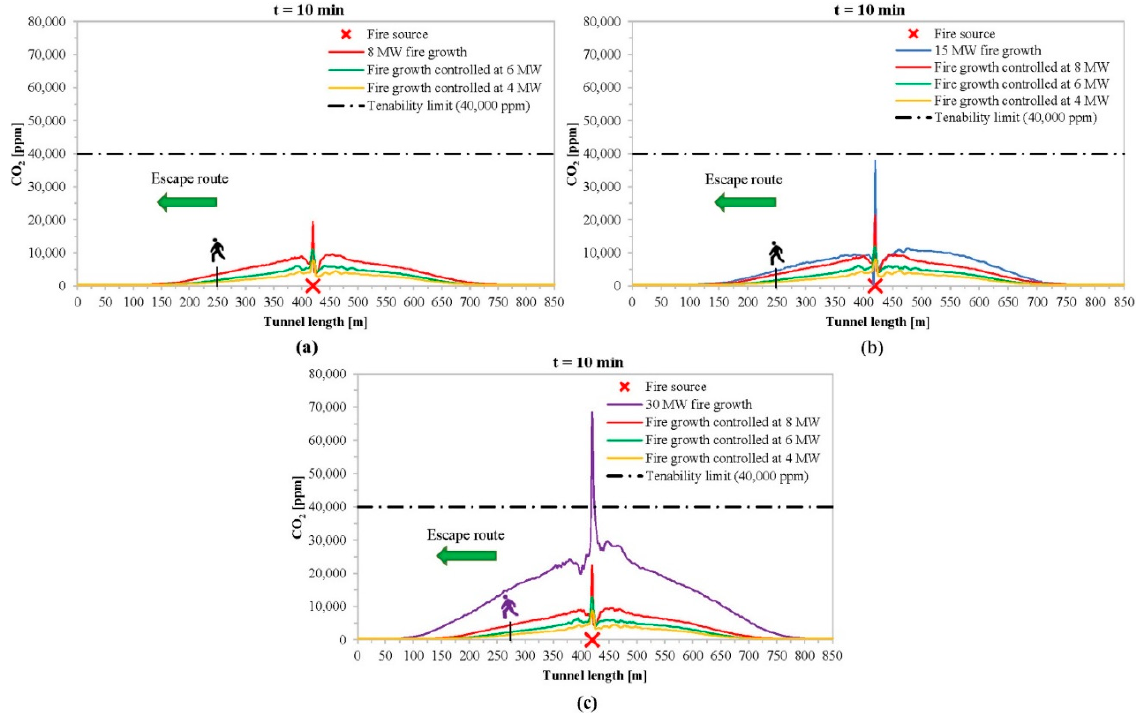
Figure 13. Profiles of longitudinal CO 2 concentration at a height of 2 m along the escape route on the road carriageway after 10 min from the fire’s start when the burning vehicle is at 420 m from portal A and the micronized water system is activated before that the fire growth achieves values of: ( a ) HRR max = 8 MW, ( b ) HRR max = 15 MW, ( c ) HRR max = 30 MW.